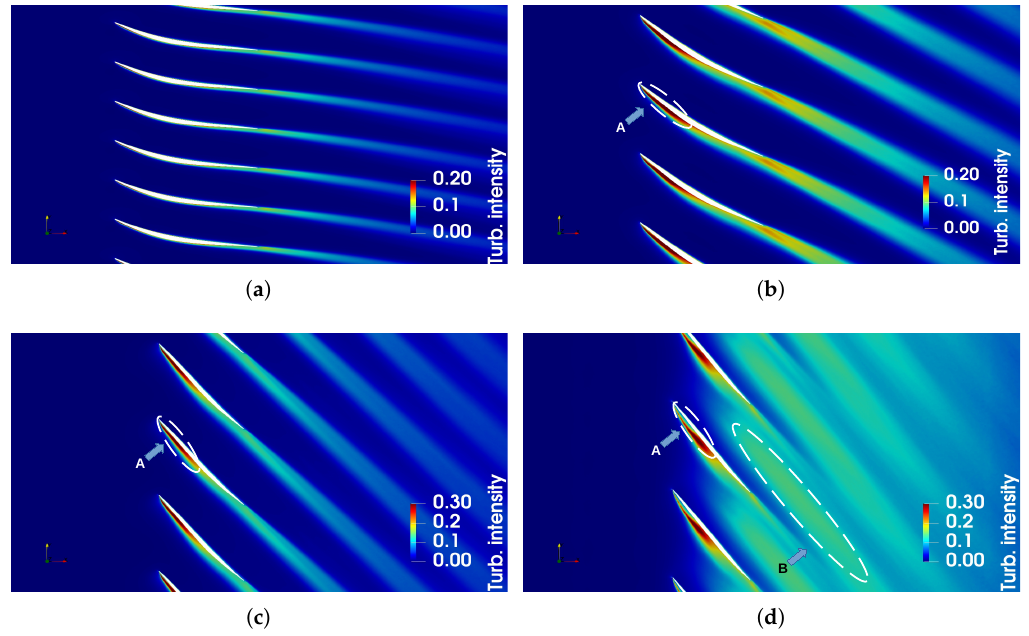
Figure 8. Turbulence intensity contours at different spanwise positions: ( a ) 25%; ( b ) 50%; ( c ) 75%; ( d )